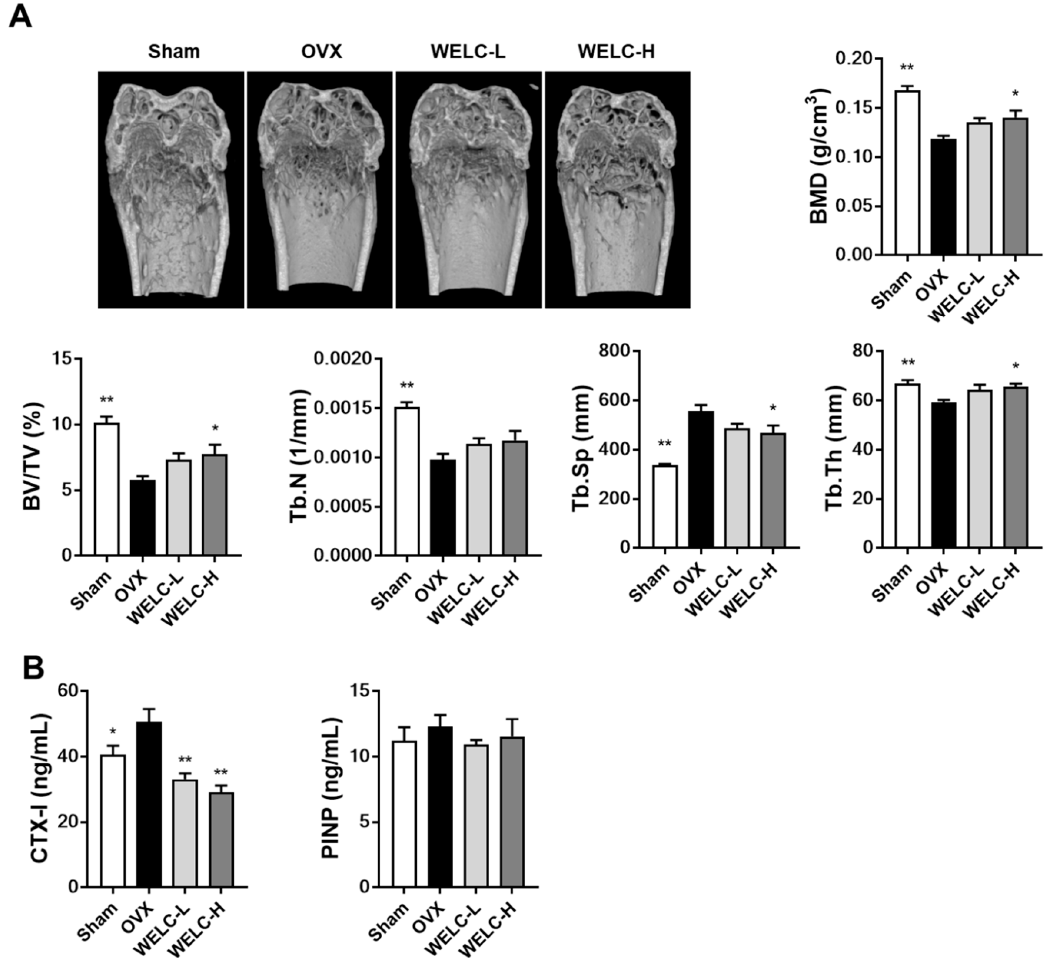
Figure 3. Inhibitory effects of WELC on OVX-induced bone loss. Sham or OVX mice were administered vehicle, WELC-L (100 mg/kg), or WELC-H (300 mg/kg) for five weeks. ( A ) The distal femora were scanned, and bone morphometric parameters (BMD, BV/TV, Tb.N, Tb.Sp, and Tb.Th) were analyzed. ( B ) Serum levels of CTX-I and PINP were measured. * p < 0.05, ** p < 0.01 versus OVX group. WELC, water extract of Lysimachia christinae ; OVX, ovariectomized; BMD, bone mineral density; BV/TV, trabecular bone volume fraction; Tb.N, trabecular number; Tb.Sp, trabecular separation; Tb.Th, trabecular thickness; CTX-I, cross linked C-telopeptide of type I collagen; PINP, procollagen type I N-terminal propeptide.